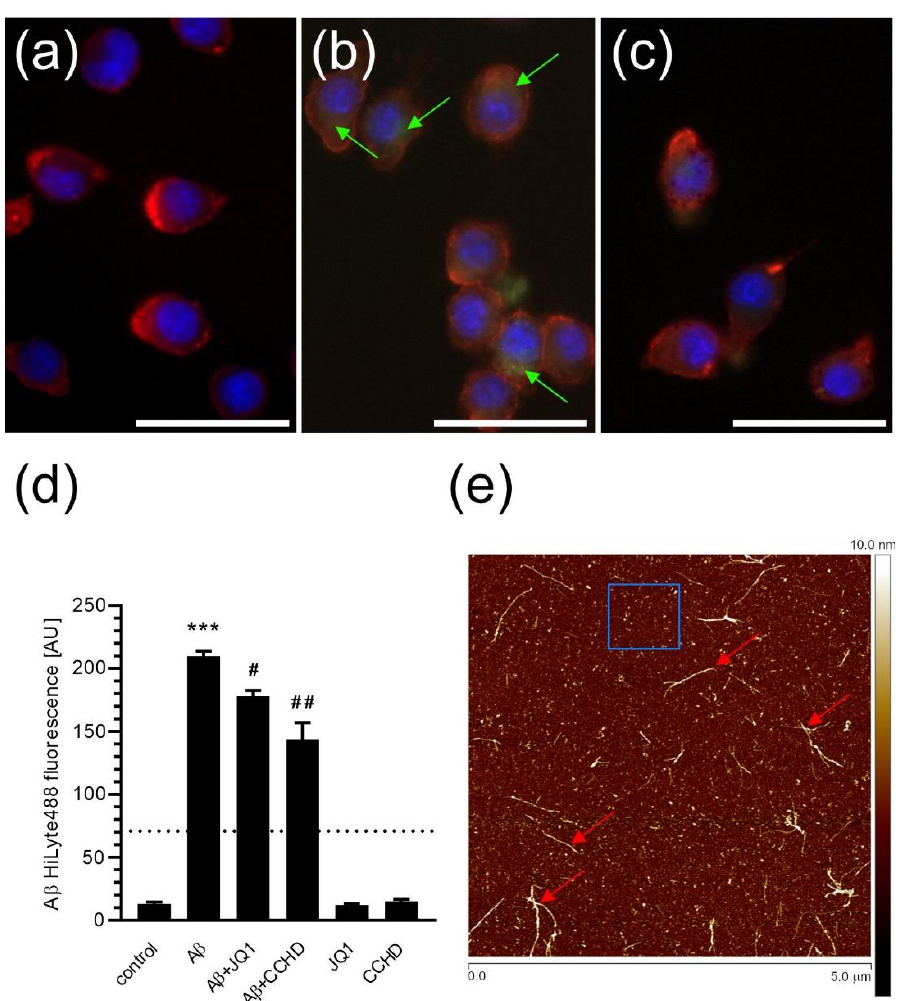
Figure 3. The effect of BET inhibitor JQ1 on A β phagocytosis by microglia. BV2 cells were preincu- bated with 50 nM JQ1 for 24 h or with 2 µ M CCHD for 30 min, and then fluorescently labelled A β 1–42 (A β HiLyte488; green on the pictures) was added. After 2 h incubation, cells were stained with red cytoplasmic dye and blue nuclear dye. ( a ) Control, ( b ) cells incubated with A β , ( c ) cells preincubated with JQ1 and incubated with A β . The scale bar: 50 µ m. Green arrows point to intracellular A β HiLyte488 staining. ( d ) Flow-cytometric analysis of the effect of the BET inhibitor and CCHD on A β phagocytosis by microglia. The dotted line shows the level of unspecific labelling with A β (at 4 ◦ C). ( e ) The typical AFM picture of A β after 2 h incubation at 37 ◦ C. Example oligomers were marked with a blue rectangle; red arrows indicate representative protofibrils. Means ± SEM are presented. n = 6–8; *** p < 0.001, compared to control, #, ## p < 0.05 and p < 0.01, compared to A β group. Statistical analysis was performed by using a one-way ANOVA followed by the Bonferroni post hoc